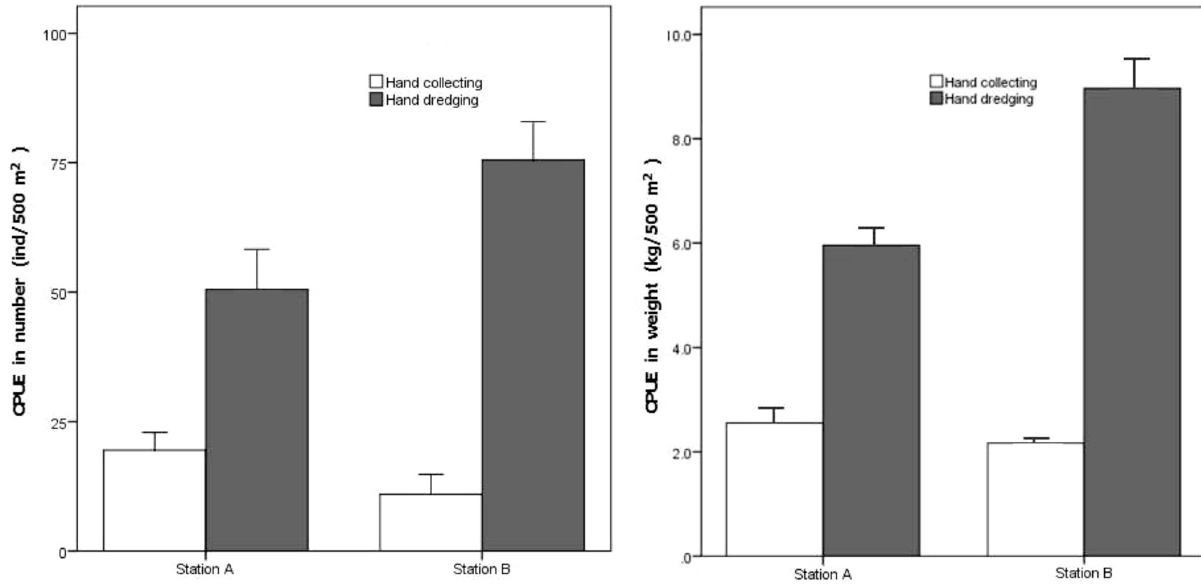
Fig. 4. Fishing yield (CPUE's in number and weight) of the hard clams caught by hand collecting and hand